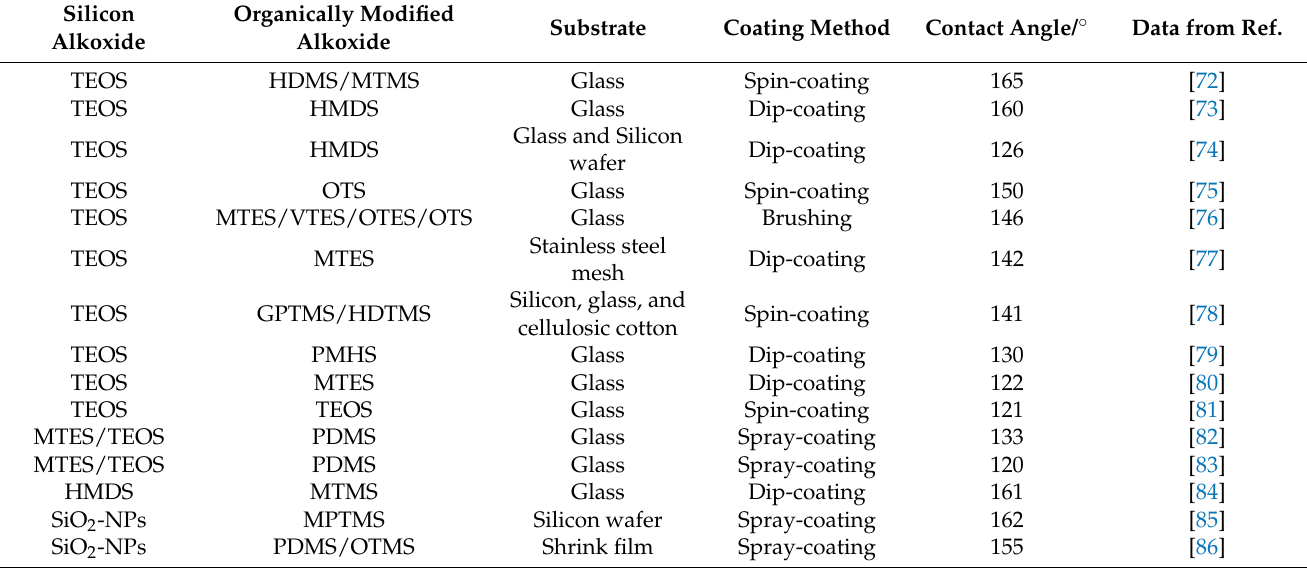
Table 3. Hydrophobic modified silica